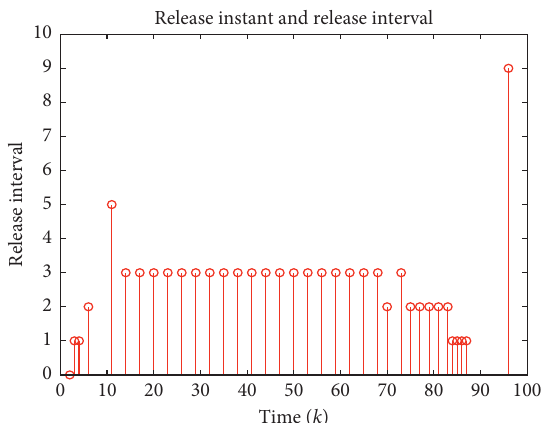
Figure 10: The release instants and their interval in Example